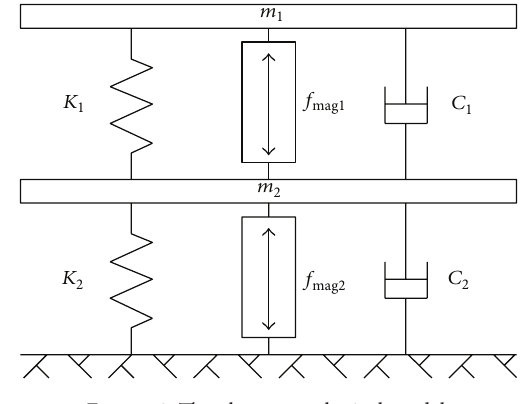
Figure 3: The phenomenological model.